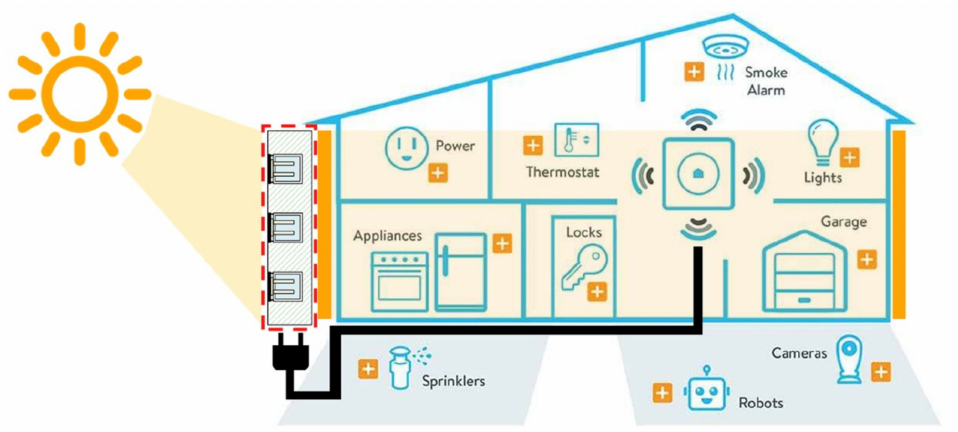
Figure 4. Application of the TEG-PCM brick wall [51]. Reprinted from Renewable and Sustainable Energy Reviews, Phase change material-integrated thermoelectric energy harvesting block as an independent power source for sensors in buildings, Yoo-Suk Byon, Jae-Weon Jeong, 128, 109921, Copyright 2020, with permission from